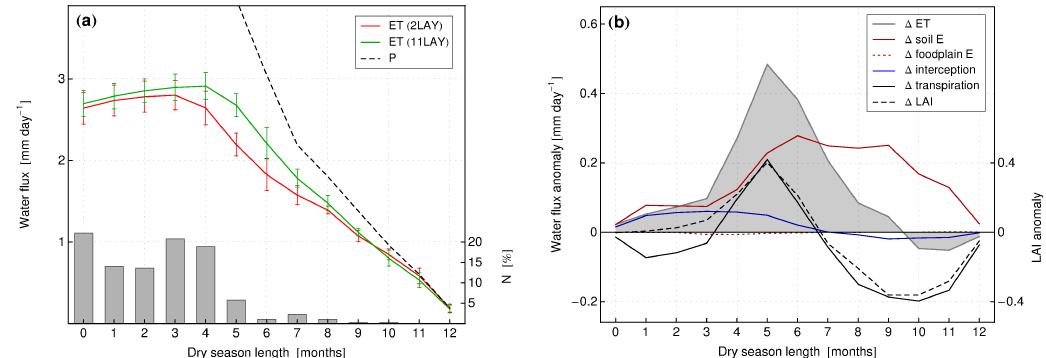
Figure 8. (a) Mean annual ET (mmd − 1 ) from simulations (2LAY and 11LAY) and Sheffield precipitation (mmd − 1 ) over the Amazon Basin as functions of the dry season length (DSL in months, see Sect. 4.5 for its definition). Solid lines represent the mean ET and spread (1SD) within moving bins of DSL of 1month, according to the two simulations. The values are obtained from individual grid cells of the simulated domain. Density of grid cells ( N in %) associated with each DSL value is given in the histogram. (b) Differences of mean annual ET (mmd − 1 ), its components (mmd − 1 ) and LAI (m 2 m − 2 ) between the 11LAY and 2LAY according to the DSL, over the Amazon Basin, for the period